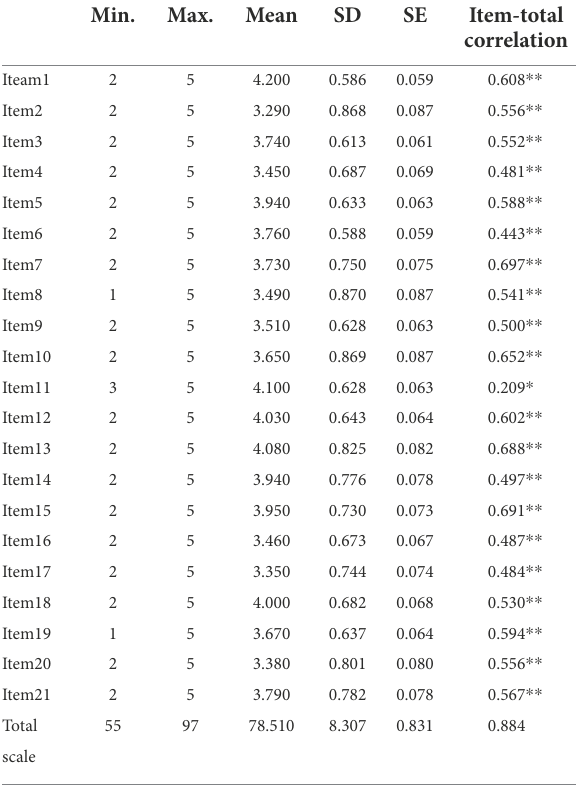
TABLE 2 Basic assessment conditions, internal consistency and Item- total correlation of the ECS scale. Min.